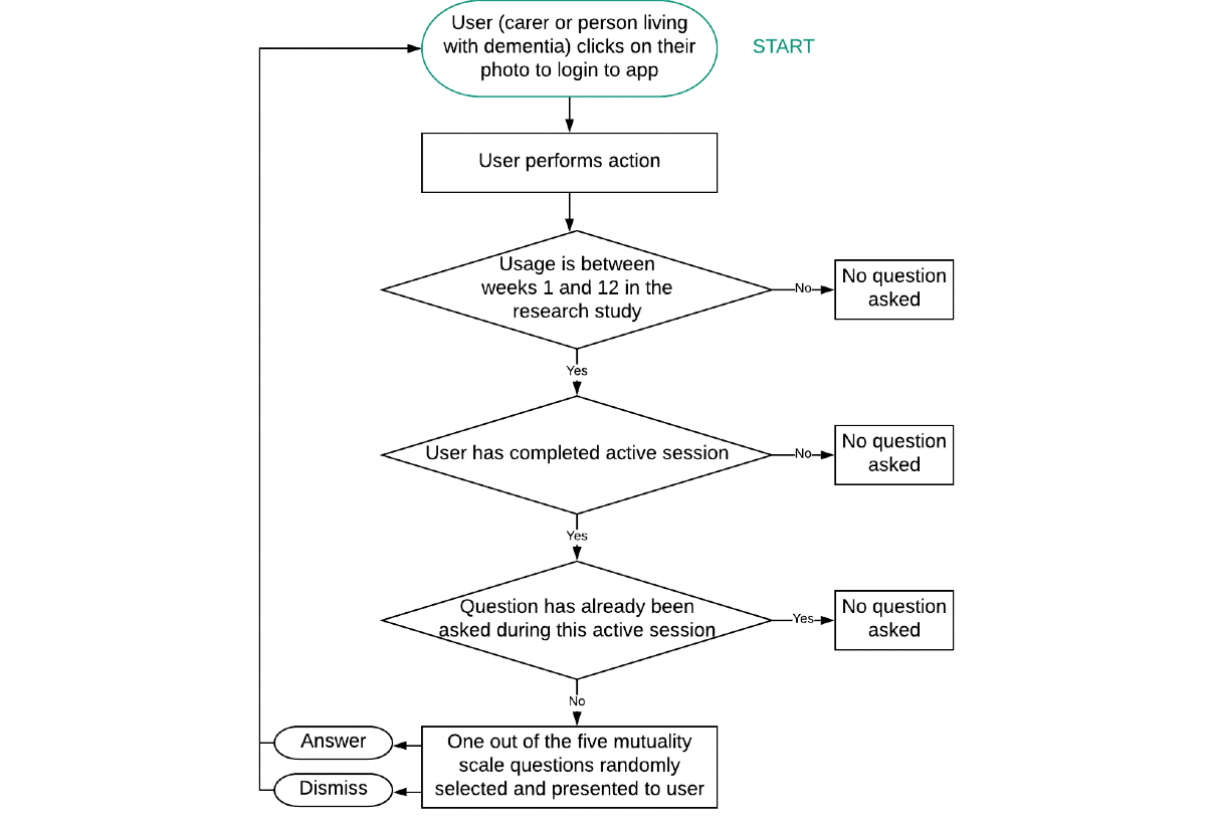
Figure 1. Logic flowchart for ecological momentary assessment questions presented to people living with dementia and their caregivers (carers).